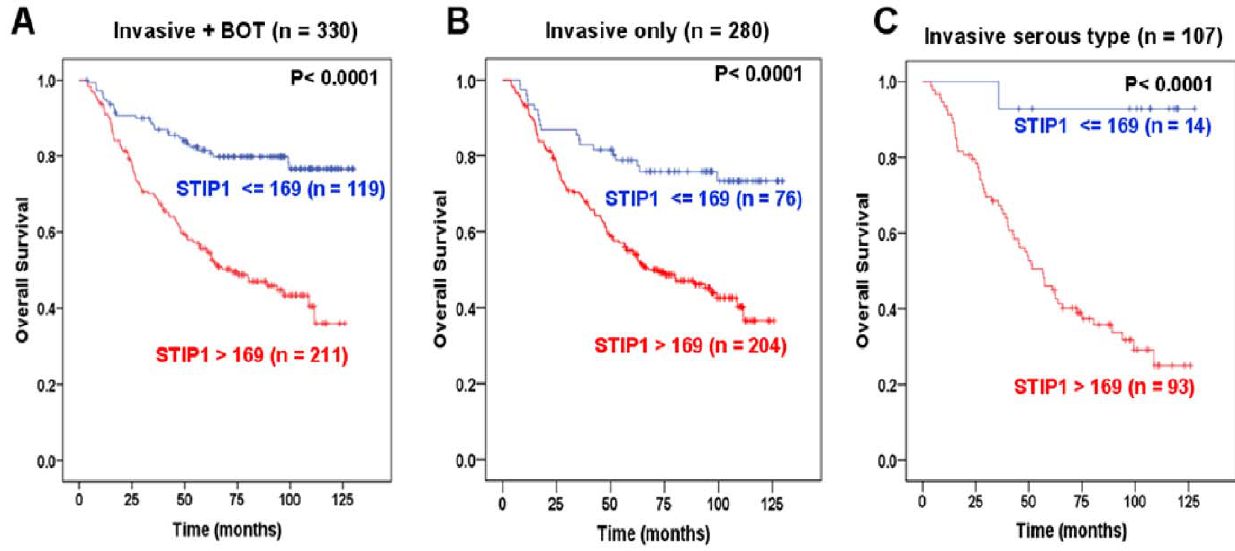
Figure 2. High STIP1 histoscores are associated with a reduced overall survival. Kaplan-Meier curve analyses for overall survival showed that women with a STIP1 histoscore . 169 (red line) had a significantly lower overall survival than those with a STIP1 histoscore # 169 (blue line). Statistical significances ( P , 0.0001) were detected in the analyses of (A) all cases (n=330) including invasive cancer and borderline tumor (BOT), (B) invasive ovarian cancers of all cell types (n=280), and (C) only invasive serous type of ovarian cancers (n=107).